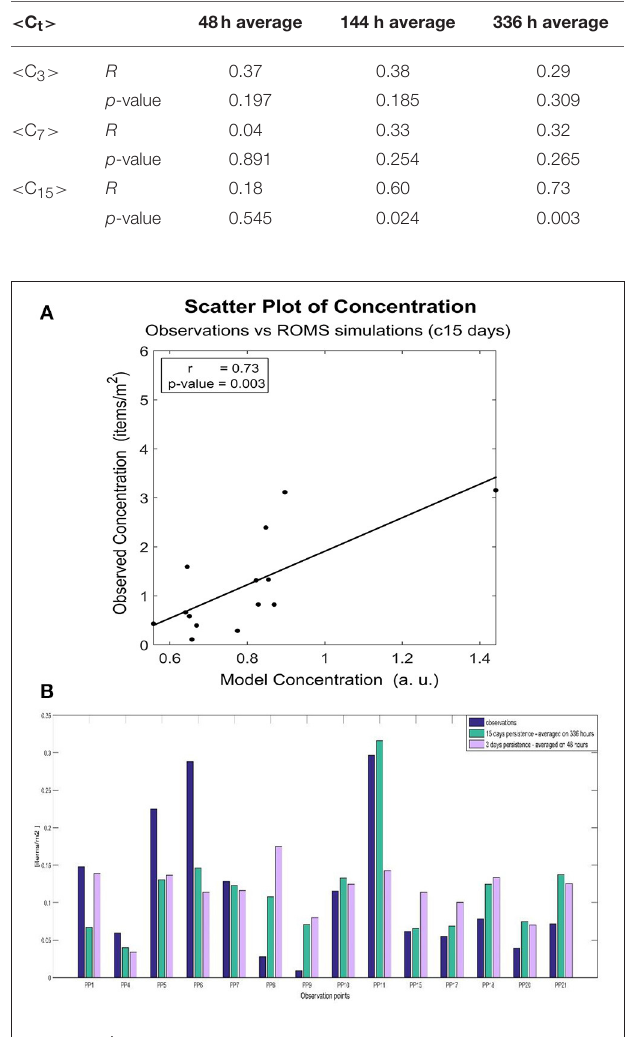
FIGURE 7 | Comparison of microplastic concentrations observed and the model estimations. (A) Scatter plot of microplastic concentrations: observation vs. ROMS simulation (15-days centered average case), (B) Histogram of microplastic concentrations observed and modeled.